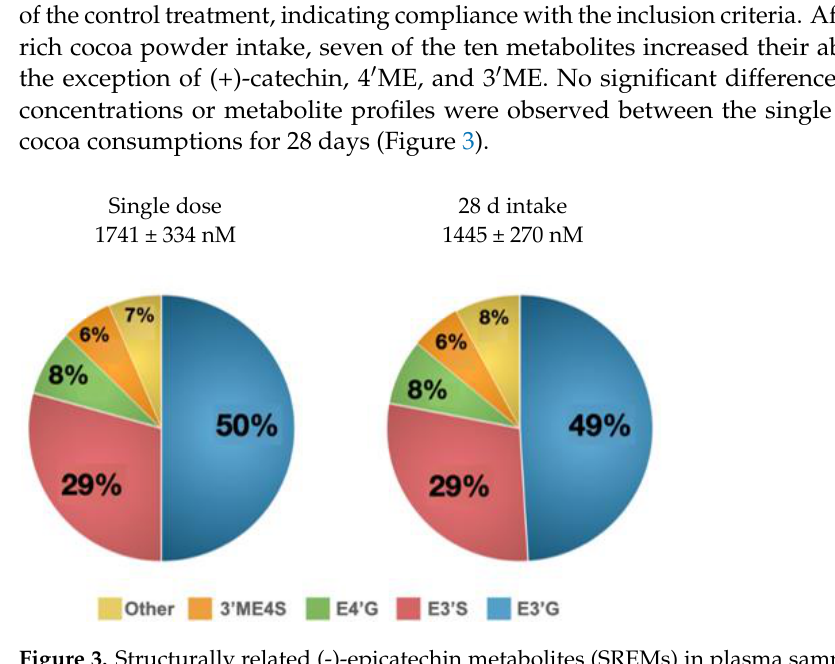
Figure 3. Structurally related (-)-epicatechin metabolites (SREMs) in plasma samples . Ten SREMs were quantified in the plasma samples by UHPLC-MS/MS. An analysis of the single dose was con- ducted at V1 and V2 ( n = 20), and the 28 day consumption was analyzed at V3 ( n = 10). The data are presented as the mean percentage after consumption. are presented as the mean percentage after consumption.